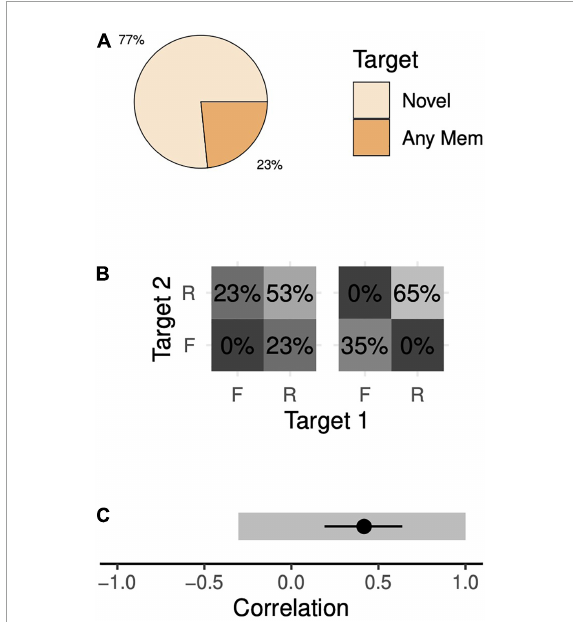
FIGURE4 Target choice probabilities and memory probabilities during the 2-item simultaneous task. (A) The trial-wise probabilities of the animal choosing either the novel target or a memory target (either target 1 or 2) given that the animal chose a target (i.e., the animal moved his eyes to within 4.5 dva of either the novel target or a memory target). The animals rarely failed to choose a target after leaving the fixation point (4% of trials, see Supplementary Figure 4 ). (B) We assume a model in which the probabilities of choosing targets depend on the probabilities of